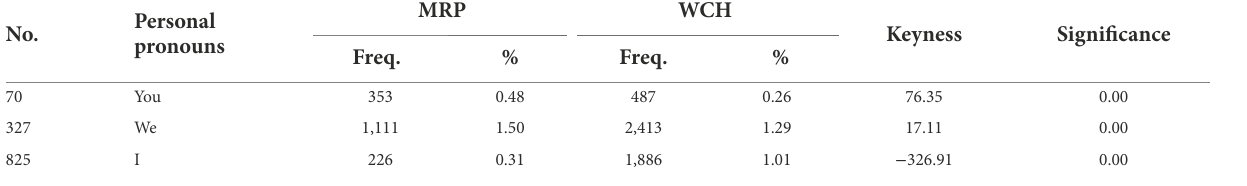
TABLE 6 Key personal pronouns in MRP (in comparison with